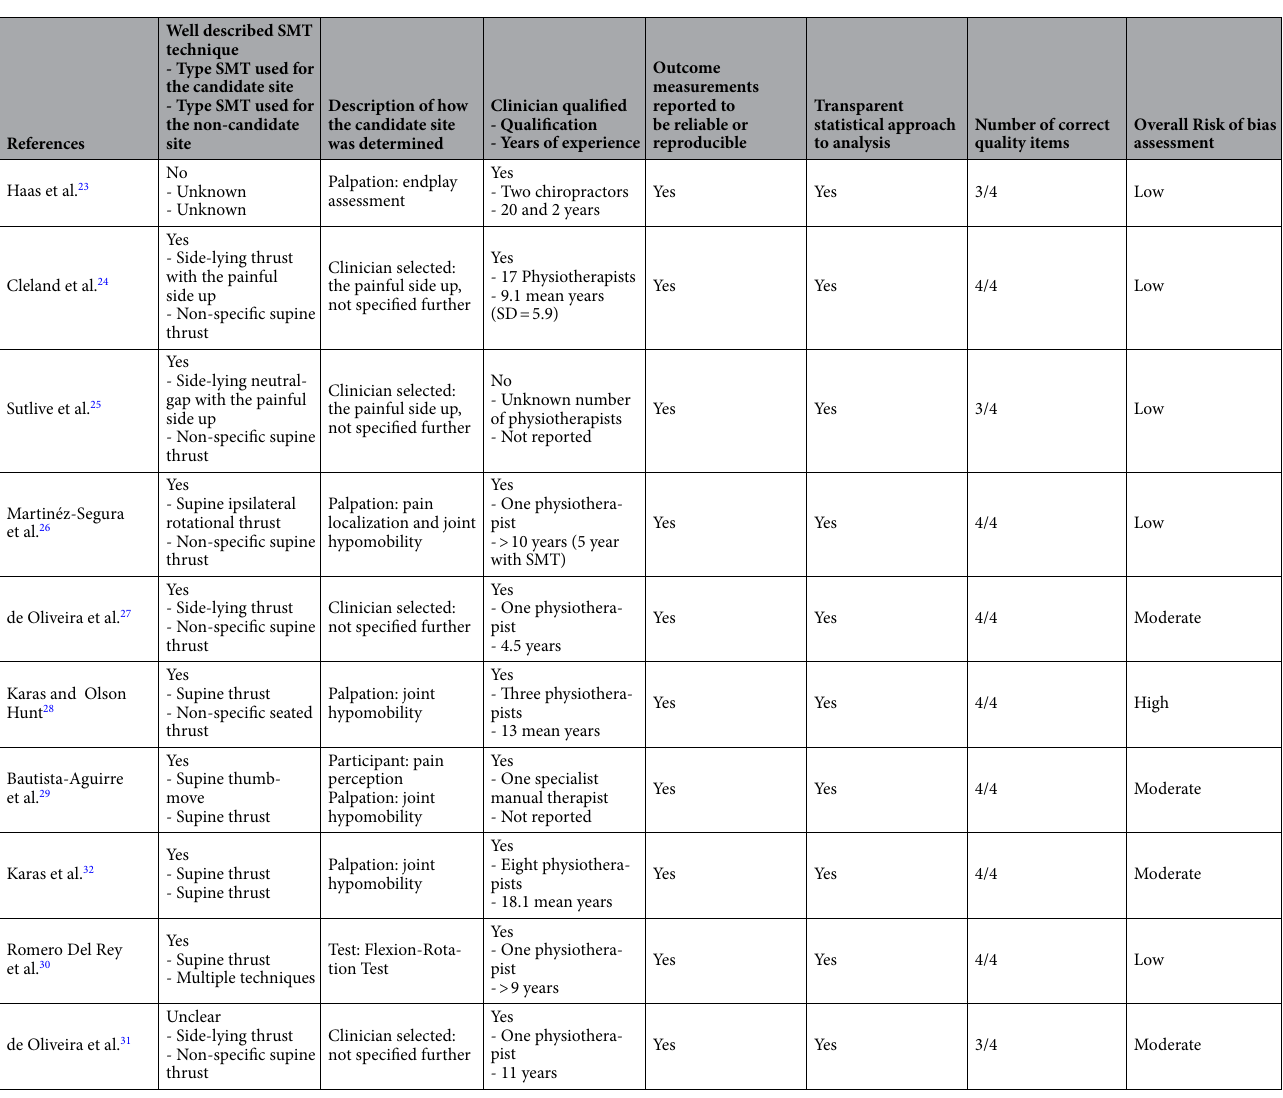
Table 2. Quality and risk of bias assessment of 10 studies included in a systematic review comparing the outcome of applying spinal manipulative therapy at a candidate site versus a non-candidate